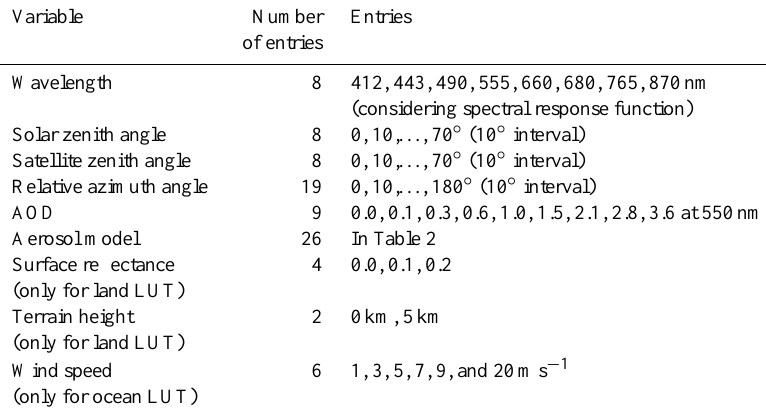
Table 4. LUT dimensions.